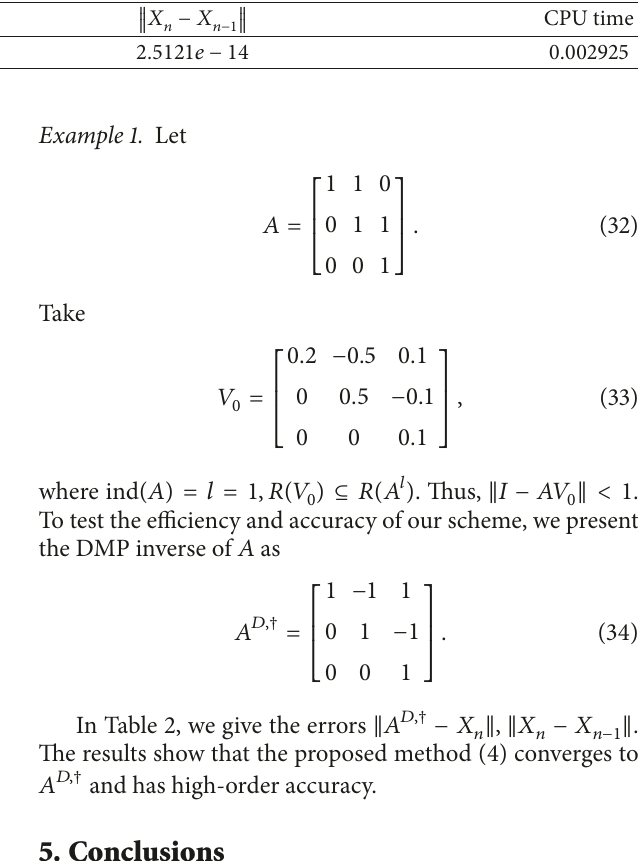
Table 2: Numerical results of Scheme II (28) in Example 1 in Section